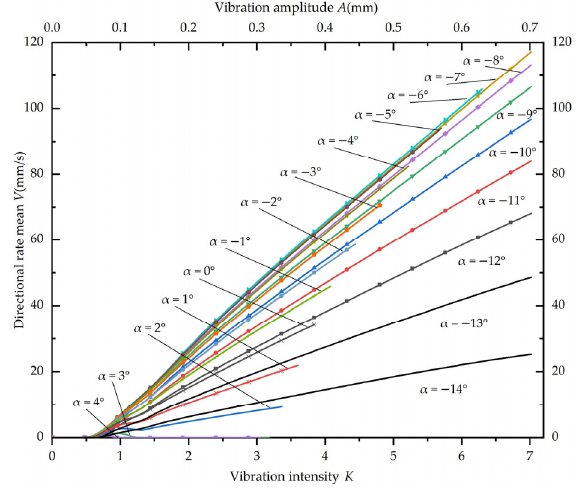
Figure 6. The trough is silicone with many small